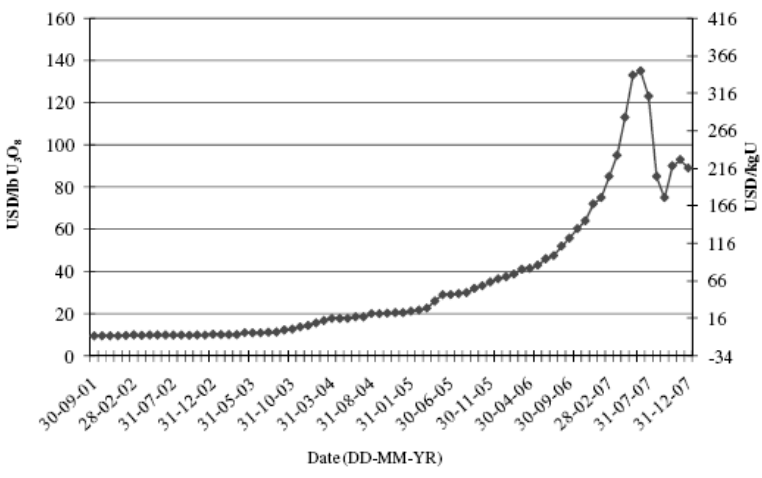
Figure 19. Uranium price trends 2001–2007. © 2008 OECD, reproduced from [96] with permission.